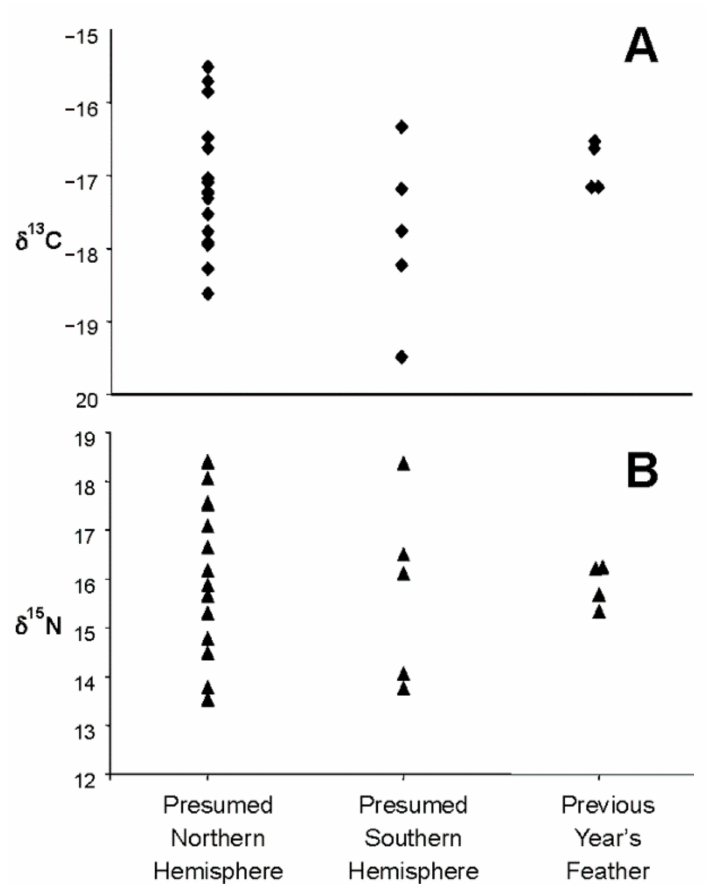
Figure 2. The δ 13 C (Panel A) and δ 15 N (Panel B) of the p6 feathers from great shearwaters collected in July 2014 and July 2015. P6 feathers from birds with incomplete molts were presumed to have grown